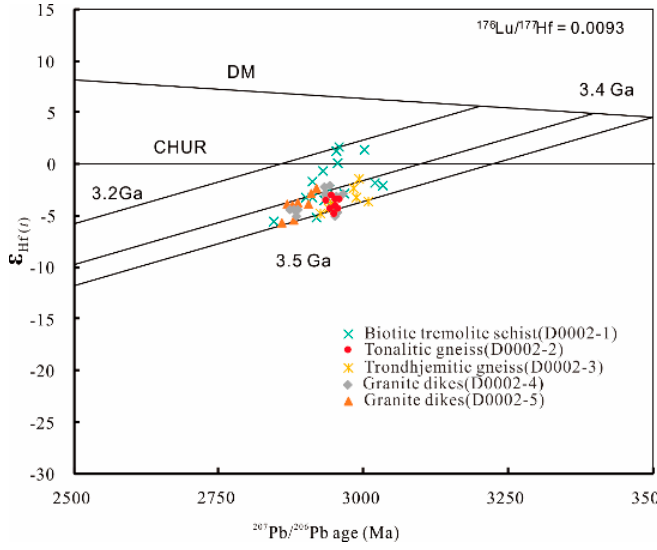
Figure 19. ε Hf(t) versus 207 Pb/ 206 Pb zircon age diagram for the biotite–tremolite schists, tonalitic gneisses, trondhjemitic gneisses, and granitic dikes.